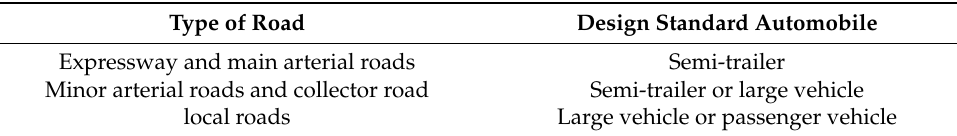
Table 1. Definition of the design standard automobile by road